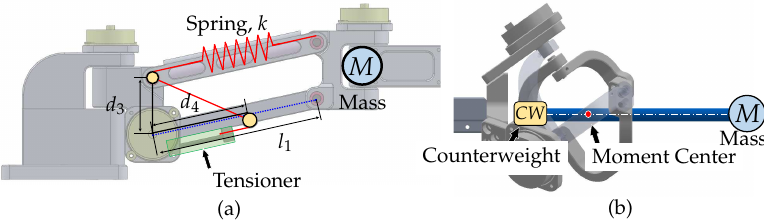
Agile Eye, (d) Yaw motion of the Agile Eye, (e) Roll motion of the Agile Eye.